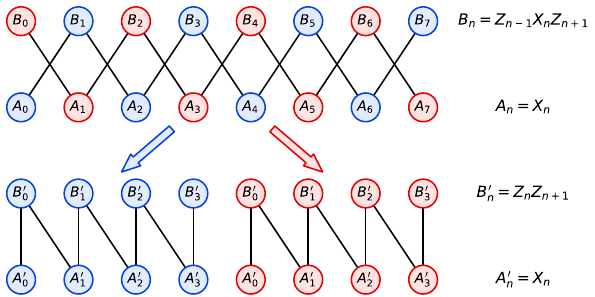
FIG. 7. The frustration graph for the f X; ZXZ g MOM (top) splits into two disconnected subgraphs that correspond to the f X; ZZ g MOM (bottom). The two models have identical puri- fication phase diagrams and critical properties, up to a factor of 2 in the entanglement entropy.